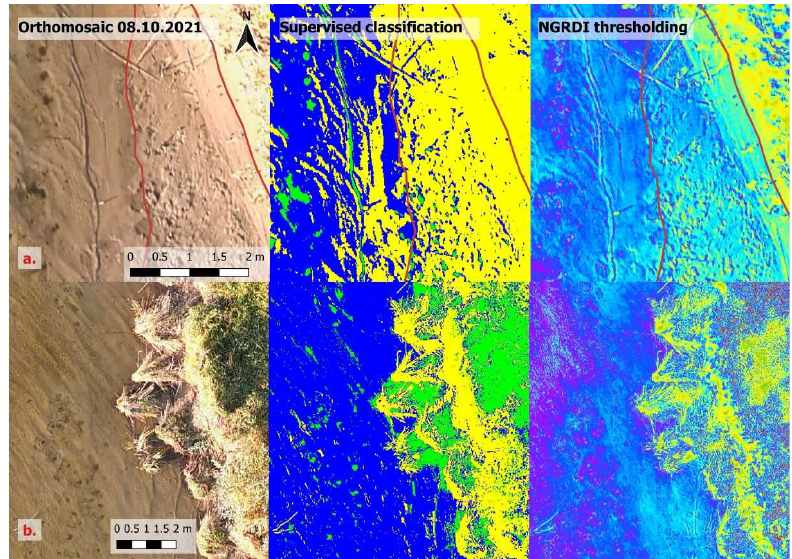
Figure 4. Shoreline detection using supervised classification of orthomosaic and NGRDI thresholding for different shore conditions: a —shallow sandy shores; b —steep banks covered with land vegetation.